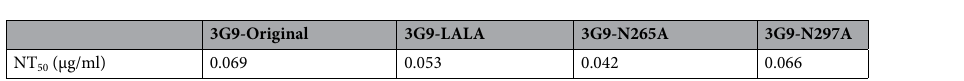
Figure 3. ADE activity of the HuMAbs. The DENV-2 NGC strain and K562 cells were used. Dotted lines indicate the baseline of the infected cells in control (100 infected cells; 2.0). Each data point represents the average obtained from two independent ADE assays.